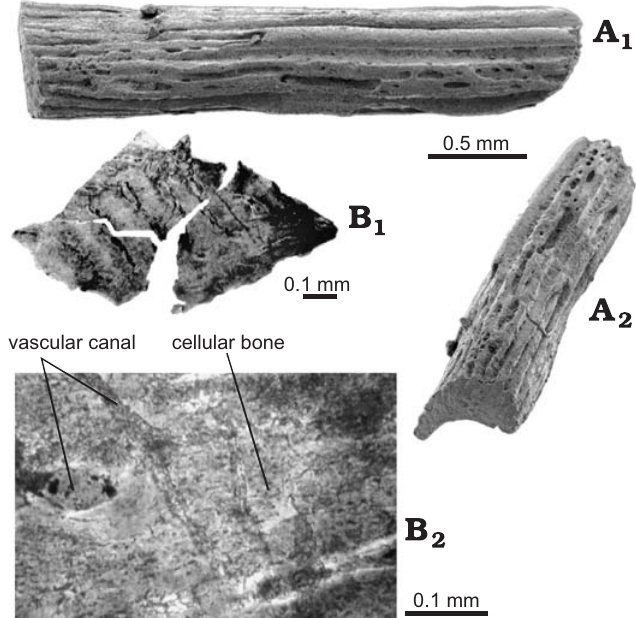
Fig. 11. Diplacanthid spine morphology and histology. Early Frasnian, ho− rizon GI4 of an unnamed formation in the Chahriseh section, Kaftari Mt., central Iran. A . AEU 320, fin spine in lateral (A 1 ) and leading edge (A 2 ) views. B . Histological microstructure of a diplacanthid fin spine. Vertical transverse section LIGG 3807 of spine fragment which had two rounded− quadrangular sculptural ribs (lost during sectioning, but were positioned at top). B 1 , general structureof an osseous vascularisedtissueembracing all of the preserved spine; B 2 , abundant osteocyte cells densely displaced among the large vascular canals appeared in two perpendicular directions, longitu− dinal and